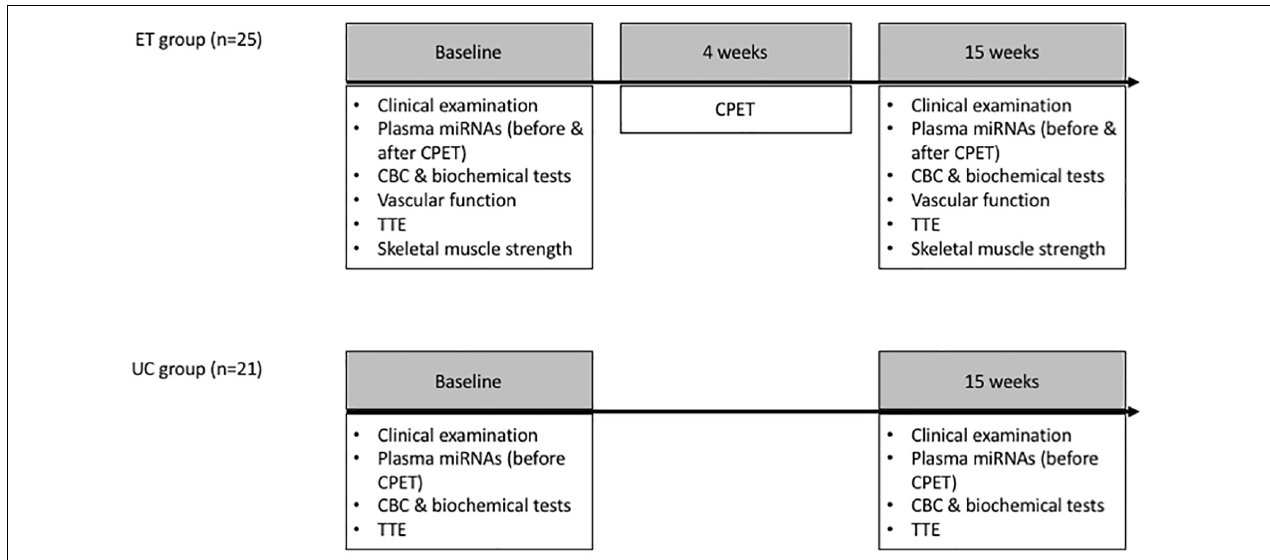
FIGURE 1 | Study design: Plasma miRNA levels were assessed at baseline and after 15 weeks in the ET and UC group. Vascular function, strength characteristics and the effect of an acute exercise bout (CPET) on the miRNA levels were evaluated in the ET group only. Since the relation between miRNAs and the central/peripheral determinants of VO 2 peak (e.g., endothelial function and skeletal muscle strength) was not the primary objective of this study, these determinants were not assessed in the UC group. Vascular function measurements included flow mediated dilation of the brachial artery, pulse wave velocity and heart rate corrected augmentation index. Maximal strength of quadriceps, pectoral, latissimus dorsi, triceps, and deltoid muscles was assessed. CBC, complete blood count; CPET, cardiopulmonary exercise test; ET, exercise training; TTE, transthoracic echocardiography; UC, usual